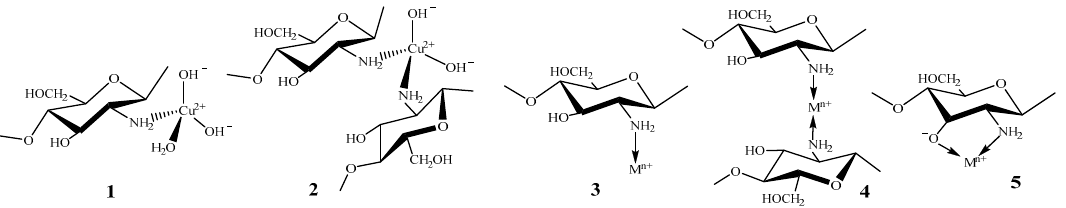
Figure 10. Suggested structures of complexes with chitosan: 1 , 2 —adapted from [142]; 3, 4 , 5 —adapted from [148].